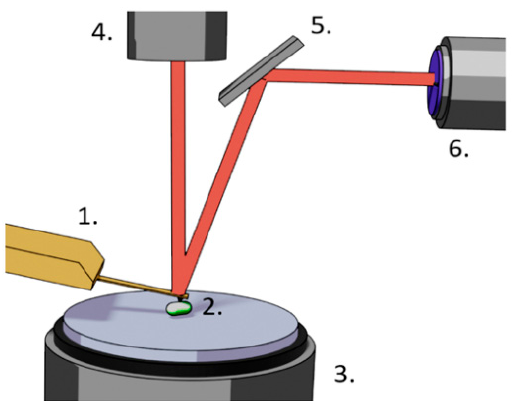
Figure 1. Components of a typical atomic force microscope (AFM). 1. Cantilever holding chip, cantilever and tip, 2. sample, 3. piezo electric sample holding stage, 4. laser, 5. mirror, 6. two- or four-segment photodiode.